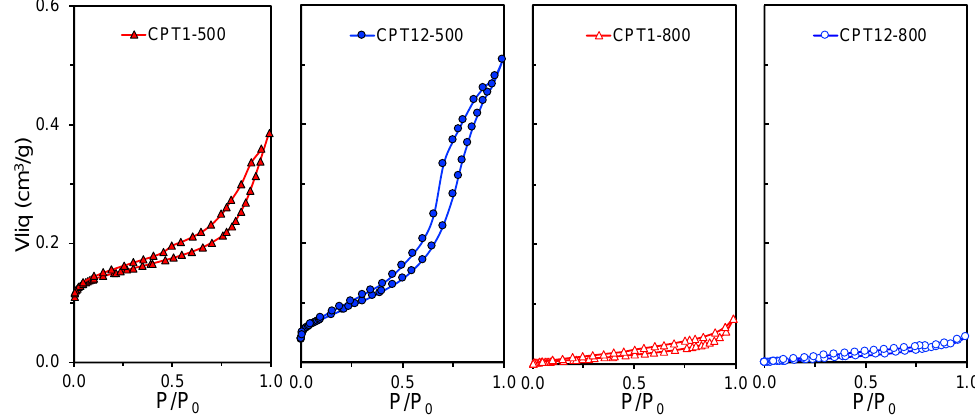
Figure 4. N 2 -adsorption isotherms of carbon-phosphorus-Ti composites treated at 500 or 800 °C. Table 2. Textural properties of selected carbon-phosphorus-Ti composites treated at 500 or 800 °C. Sample